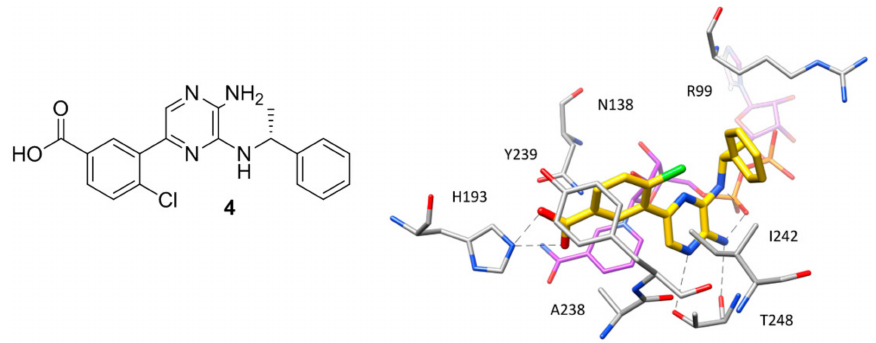
Figure 3. Chemical structure of 4 and X-ray structure of h LDH5 in complex with compound 4 (PDB code 4M49). The cofactor and active site residues interacting with the inhibitor are shown and the ligand–protein H-bonds are